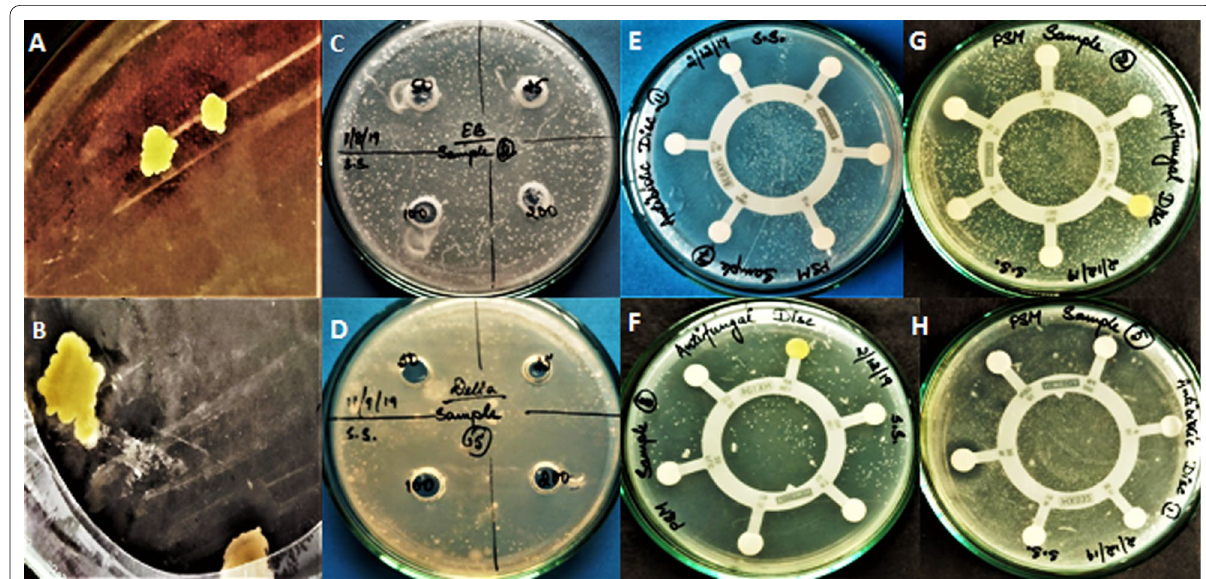
Fig. 2 A , B Transparent halos around the colonies; plates C , D pesticide, E , H antibiotic and F , G antifungal agents exhibiting different level tolerance by PSMC against antibiotic, antifungal and